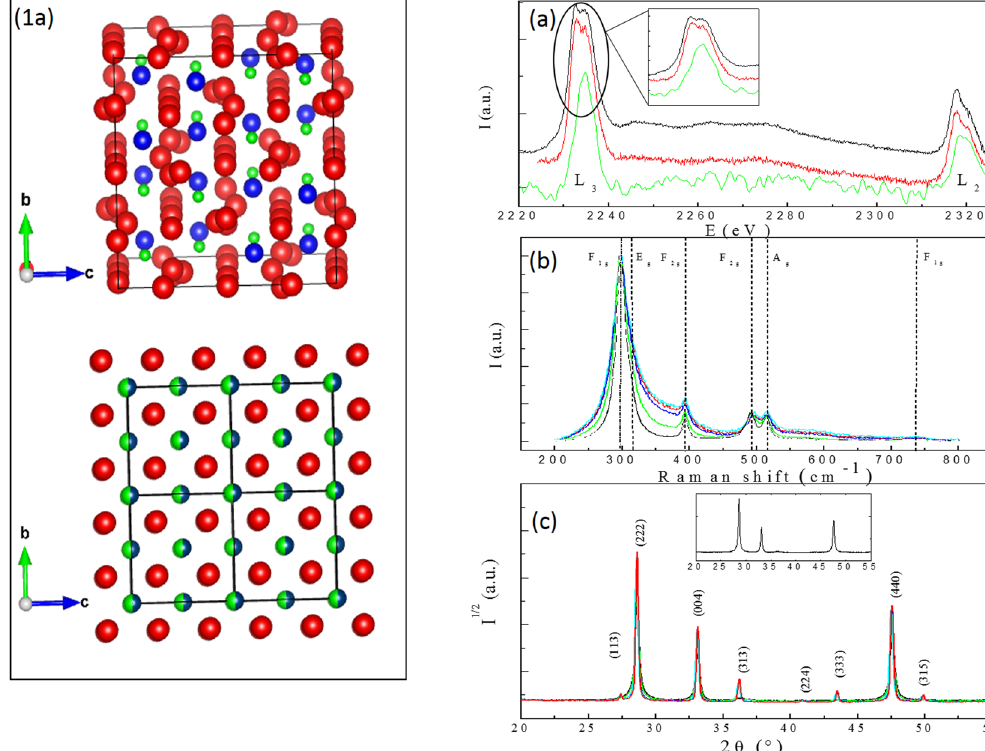
Figure 1. Description of the structures (1a), EELS ( a ), Raman ( b ) spectra and X-ray diffraction patterns ( c ) collected on the La 2 Zr 2 O 7 powders. Figure 1a is a schematic of the pristine (top) and defect fluorite (bottom) pyrochlore structure. Oxygen sites (red) are fully occupied in the pyrochlore structure and defect fluorite structure. La (blue) and Zr (green) sites in the pyrochlore structure are equivalent in the defect fluorite decreasing the unit cell by two (black squares). EELS spectra of the micrometric (red, t = 350 nm ), nanometric (black, t = 70 nm ) pyrochlores and cubic ZrO 2 (green: t = 250 nm ) are displayed in Figure a. The Raman spectra ( b ) does not vary with respect to grain size. X-ray diffraction patterns for samples with different grains sizes are plotted in figure c (black: 70 nm, blue: 120 nm, green: 150 nm, cyan: 200 nm, red: 350 nm). The loss of odd X-ray reflexions in samples with small grains is highlighted in the